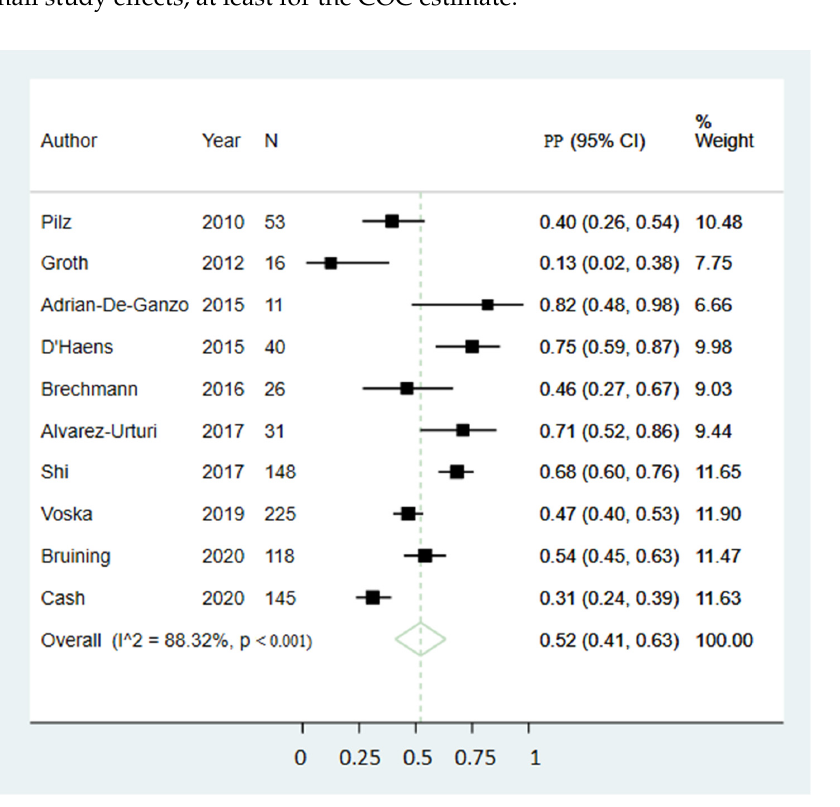
Figure 3. Pooled estimate of colonoscopy preference proportion. Abbreviations: CI, confidence interval; PP, Estimated preference proportion.